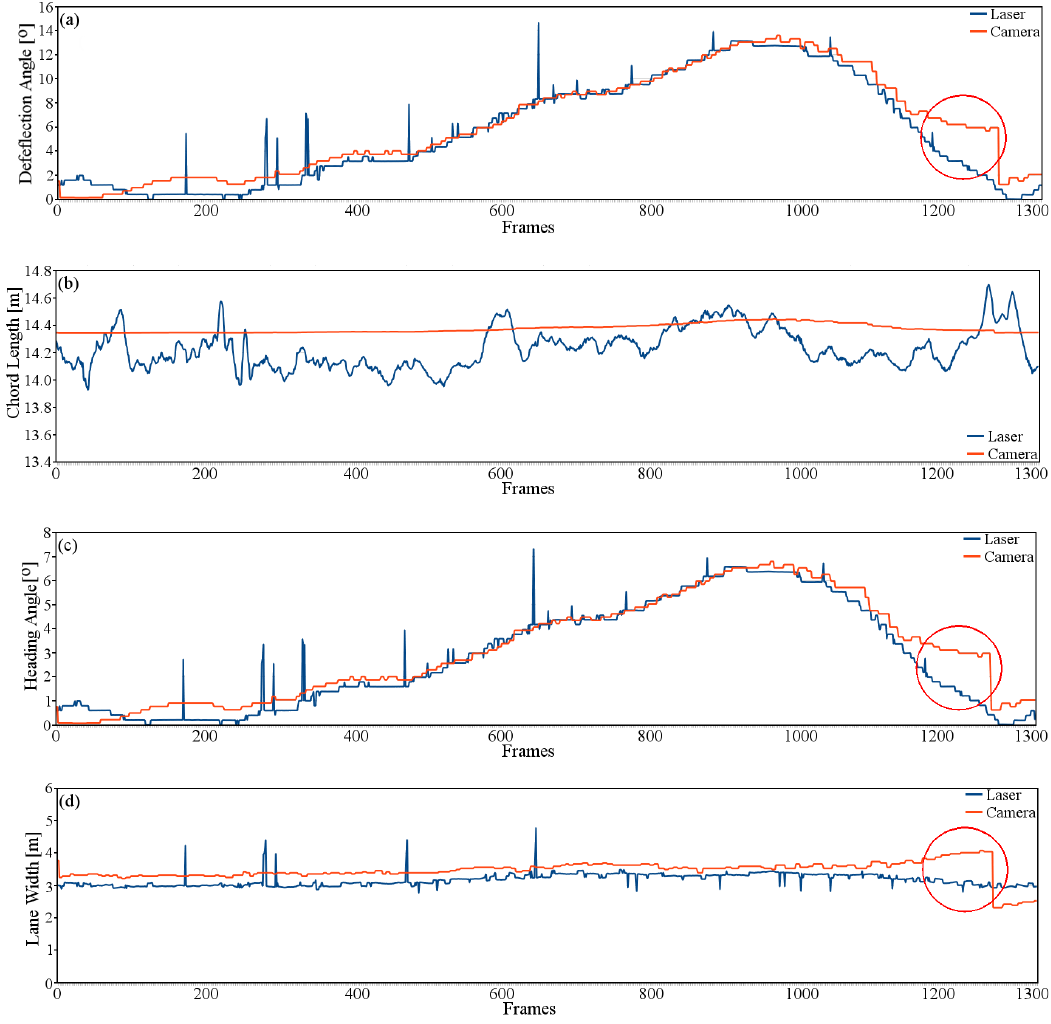
Figure 12. Road parameters evaluation using laser and camera, laser data in blue color while camera data is in orange color. ( a ) shows the deflection angle comparison; ( b ) illustrates the chord length comparison; ( c ) shows the vehicle heading angle; and ( d ) shows the lane width comparison. Circles in red shows the computed error due to abrupt change in